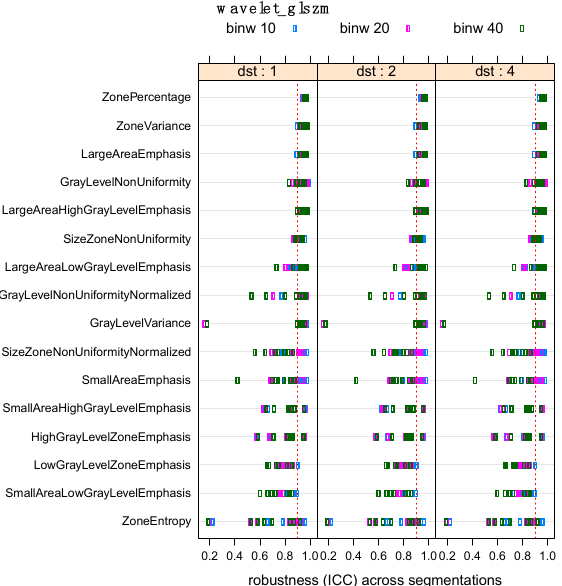
Figure 13. Robustness of wavelet-based second-order GLSZM features across segmentations. The vertical dashed red line indicates the ICC > 0.9 threshold. Pyradiomics provides 16 such features. The robustness (ICC) is above 0.9 only for few of them. They are dependent on bin-width (binw: 10, 20, 40) and on (dst: 1, 2, 4). Because they are second-order, they are dependent on distance (dst) but they do not depend much on resolution or interpolator. However, the wavelet features are dependent on the direction used for wavelet computation (each circle on a line is a different gradient direction). w avelet_ngtdm